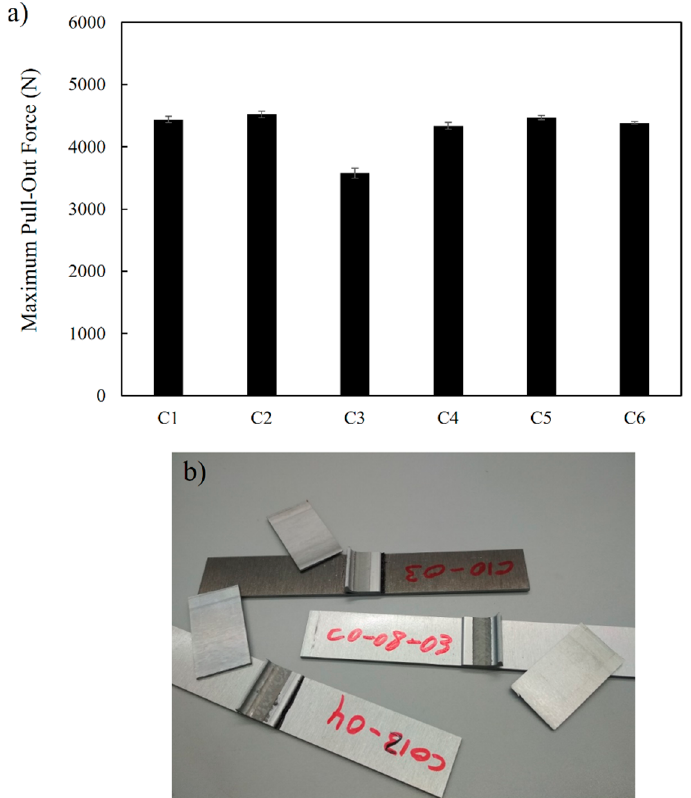
Figure 13. ( a ) Representation of maximum pull-out force values for FSW coupons C1–C6 and ( b ) examples of stringer failure in specimens obtained from FSW coupons C2, C4, and C6.